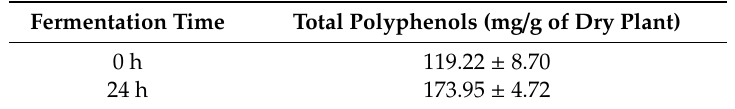
Table 3. Total polyphenols extracted by sold-state fermentation (SSF) from Castilla